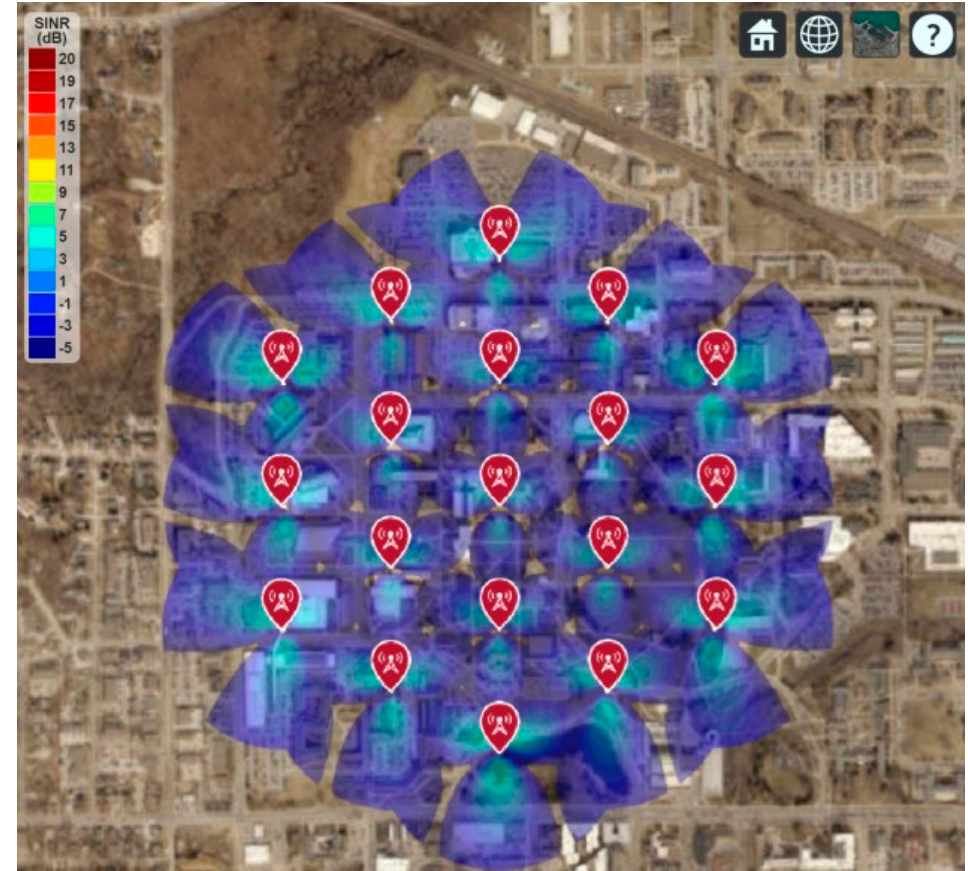
Figure 16. 5G Network Coverage and SINR Map for a single antenna element.